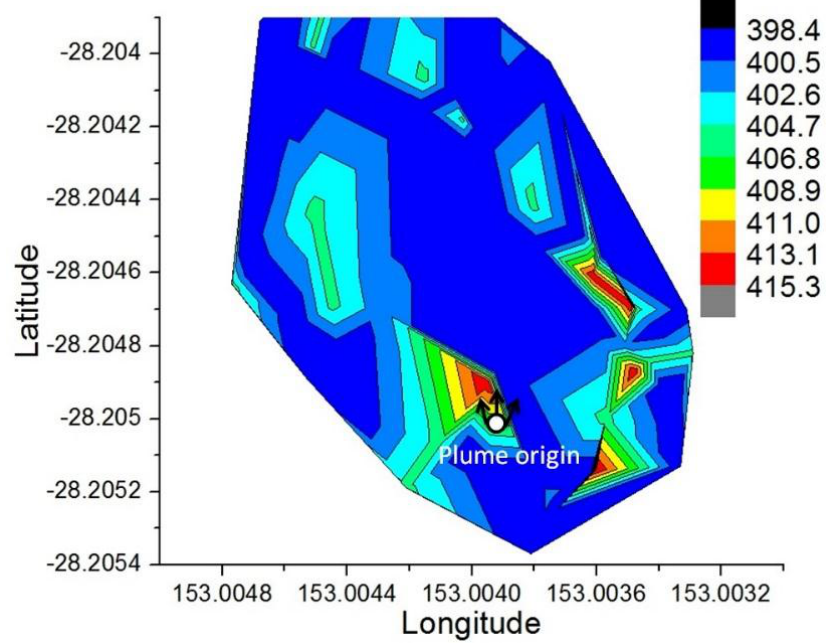
Figure 19. Contour map of the CO 2 concentration estimated by the UAV within the 3 × 10 6 km 3